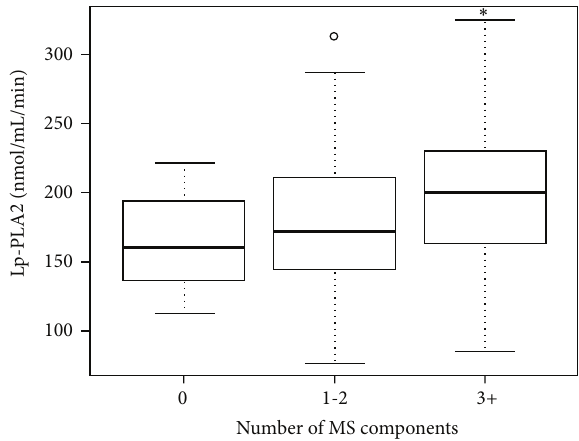
Figure 1: Levels of lipoprotein-associated phospholipase A2 by number of metabolic syndrome components. ∗ 𝑃 < 0.01 versus 0 MS components. LpPLA2: lipoprotein-associated phospholipase A2; MS: metabolic syndrome.